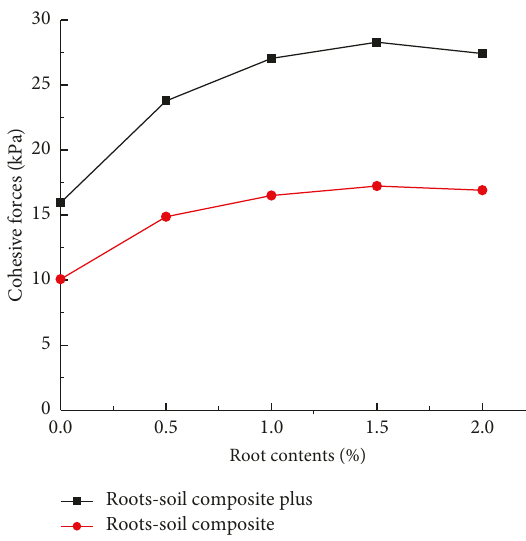
Figure 6: Comparison of the cohesion force after MICP-treated.